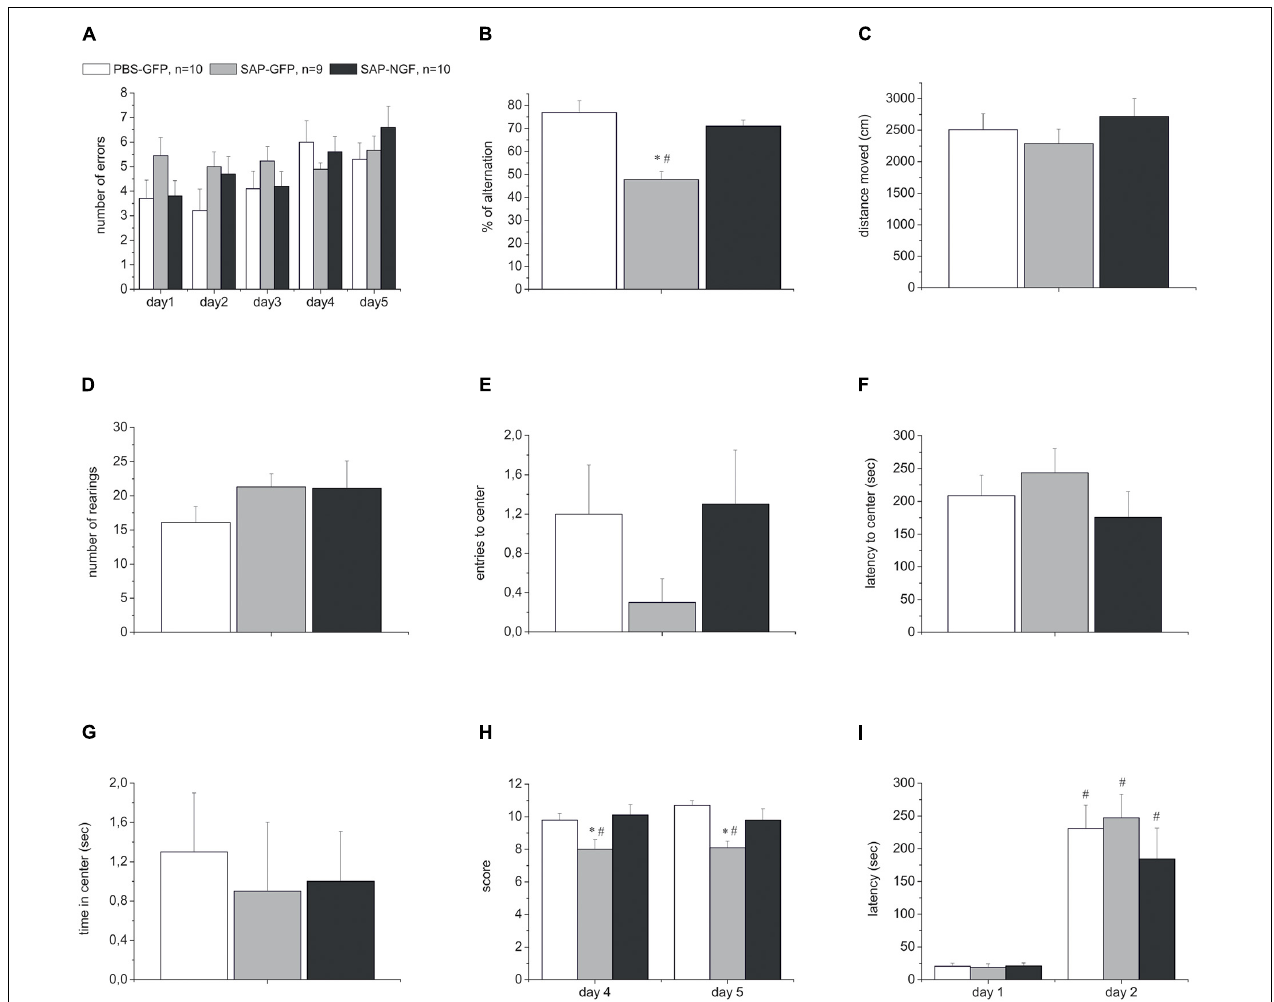
FIGURE 2 | (A) Shows the number of errors over all testing days in the T-maze test. (B) Represents percentage of correct alternations in the Y-maze test. (C–G) Show distance moved, number of rearings, number of center crosses, latency to center, and time spent in the center in the open field test. (H) Shows motor beam-walking scores. (I) Represent the latencies during the first testing day and retention trial in the passive avoidance test. All rats were injected with PBS and control virus (PBS-GFP, n = 10), 192IgG-saporin (SAP-GFP, n = 9), and with 192IgG-saporin and NGF-carrying virus (SAP-NGF, n = 10). Each point represents the mean ± SEM. ∗ Significant differences against the saline group, p < 0.05; # significant intergroup differences, p <